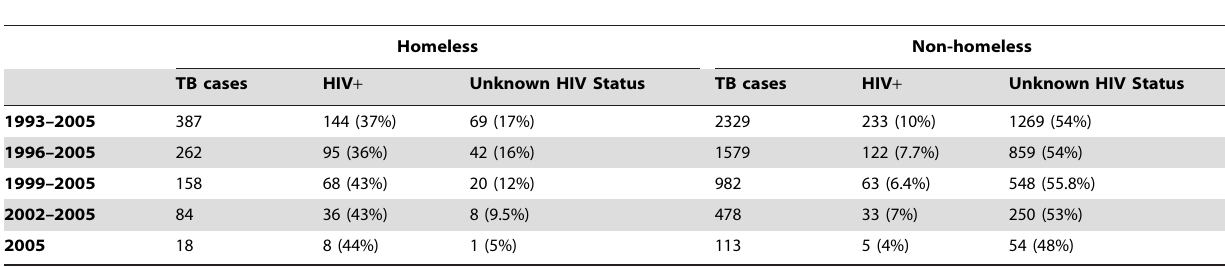
Table 1. Number of TB cases, HIV + TB cases, and TB cases with missing HIV status, in the San Francisco homeless and non-homeless